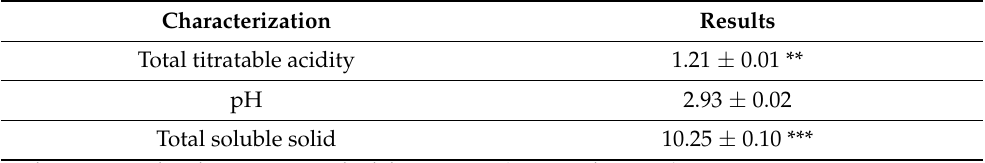
Table 2. Physicochemical characterization of blackberry pulp *.